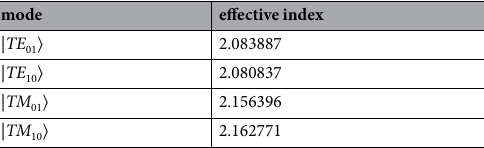
Table 1. Calculated effective indices of the guided modes in the photonic